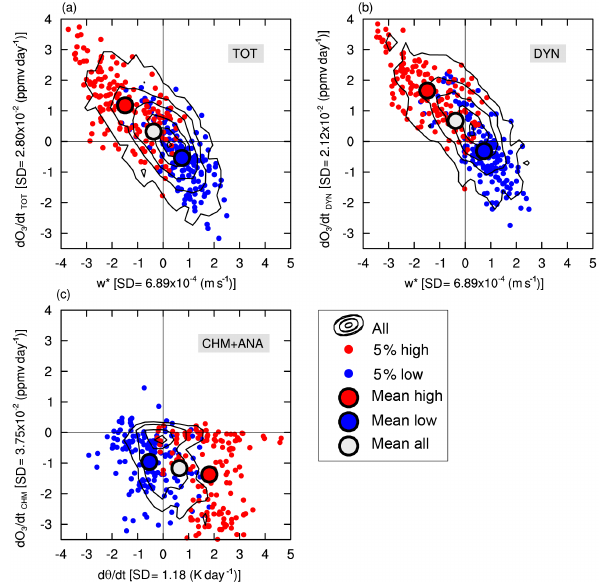
Figure 3. Two-dimensional joint probability density distribution of (a) residual vertical wind velocity versus total ozone tendency, (b) residual vertical wind velocity versus ozone tendency due to dynamics, and (c) potential temperature tendency versus ozone ten- dency due to parameterized chemistry, averaged over 60 to 90 ◦ N at 50hPa (for a, b ) and at 5hPa (for c ), in JFM from MERRA2. The axes are normalized to standard deviations in each quantity. Black contours show the probability distribution of all JFM days during 1980–2013 (contours shown are 1, 2, 3, 4, 5, ... % of total). Red and blue dots show days with 5% extreme maximum and min- imum total wave-1 meridional heat flux. Larger circles indicate the mean of the distribution of all data (gray), high extremes (red), and low extremes (blue).